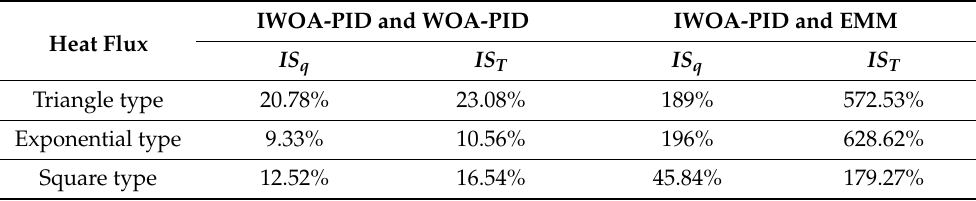
Table 2. Accuracy improvement degree under three heat flux types.